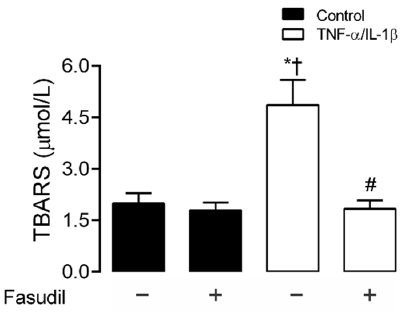
Figure 5. Blockade of ROCK prevents the increase in TBARS induced by TNF- α /IL-1 β in primary mesangial cells. Graphs showing the amount of TBARS obtained from culture media of primary MCs under control conditions (black bars) or exposed to TNF- α /IL-1 β (white bars) for 72 h. Fasudil (15 µM) was added 24 h before harvesting the cells. Each bar represents the mean value ± SEM of 4 independent experiments. Statistical significance, * p < 0.05 vs. Ctrl; † p < 0.05 vs. Control + Fasudil; # p < 0.05 vs. TNF- α /IL-1 β .